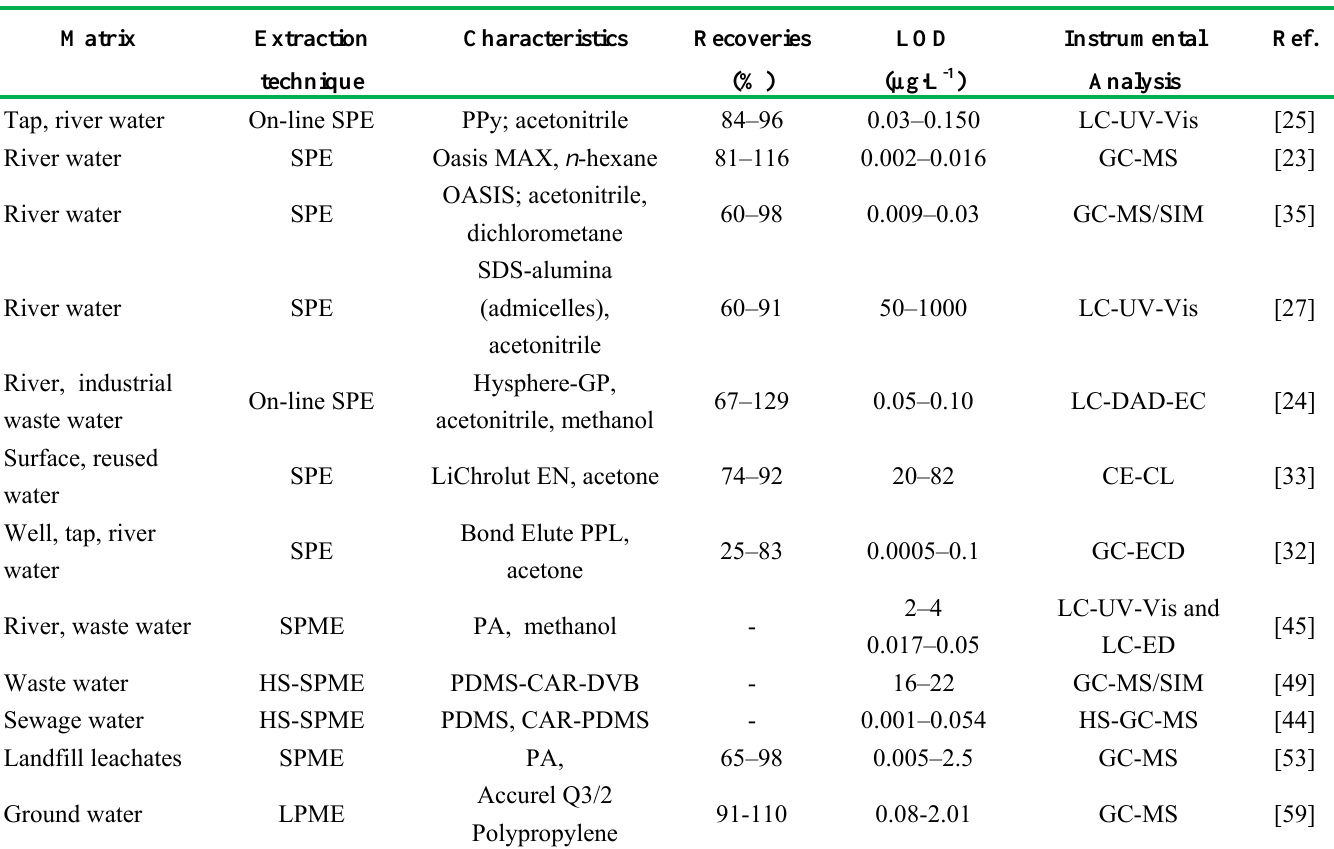
Table1 . Methods for the determination of phenolic compounds in liquid samples using organic